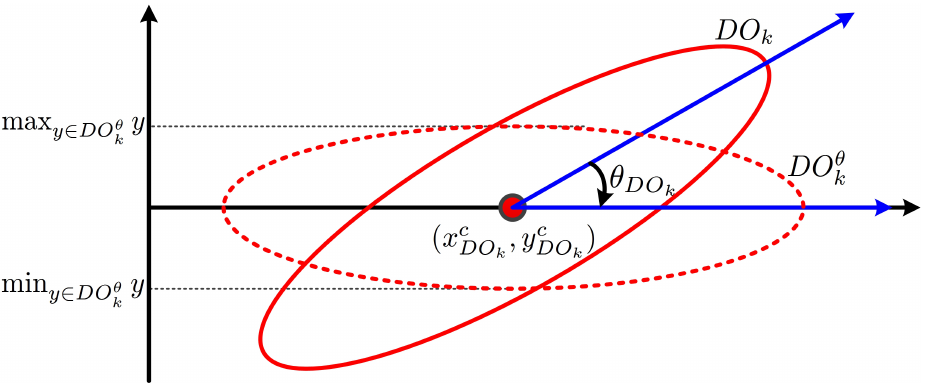
Figure 8. Finding the direction of the major axis of a matched ellipse.